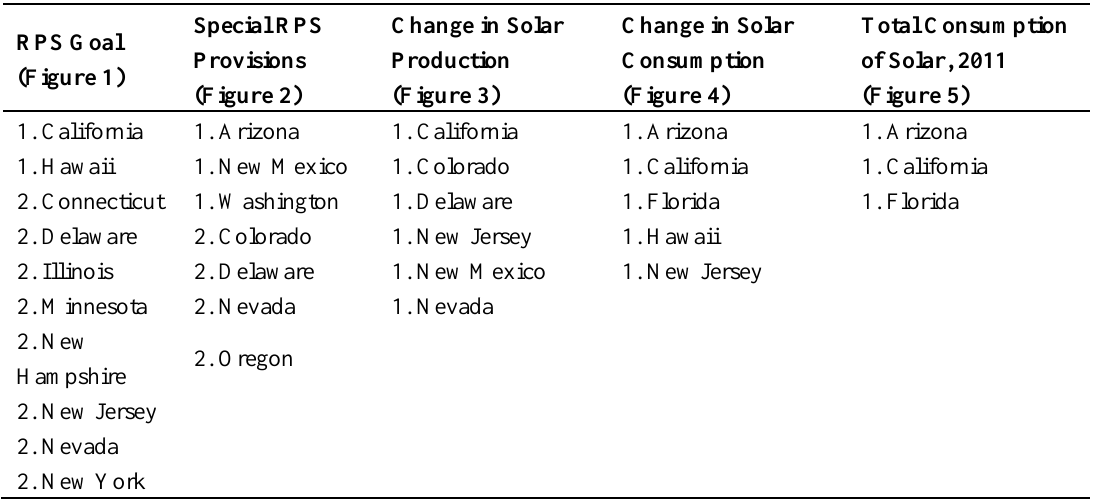
Table 2. Summary of RPS provisions for solar and changes in solar technology